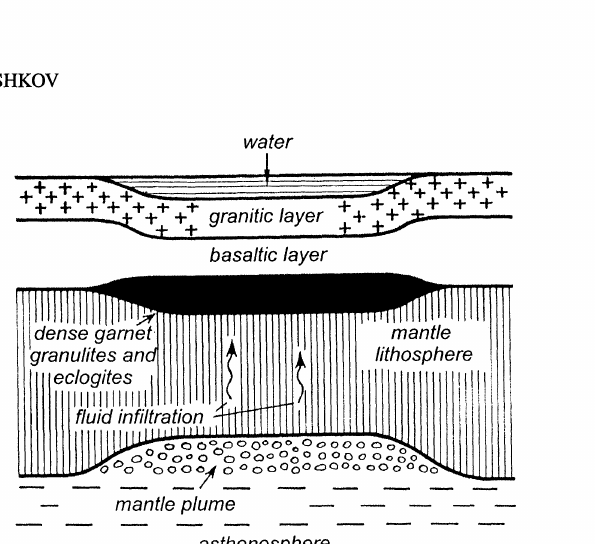
FIGURE Crustal subsidence with a formation of a deep water basin due to a transformation ofbasalts in the lower crust into denser garnet granulites and eclogites. Rapid transformation of rocks occurs under infiltration into the lower crust of fluids from a small plume of heated mantle at the base of the